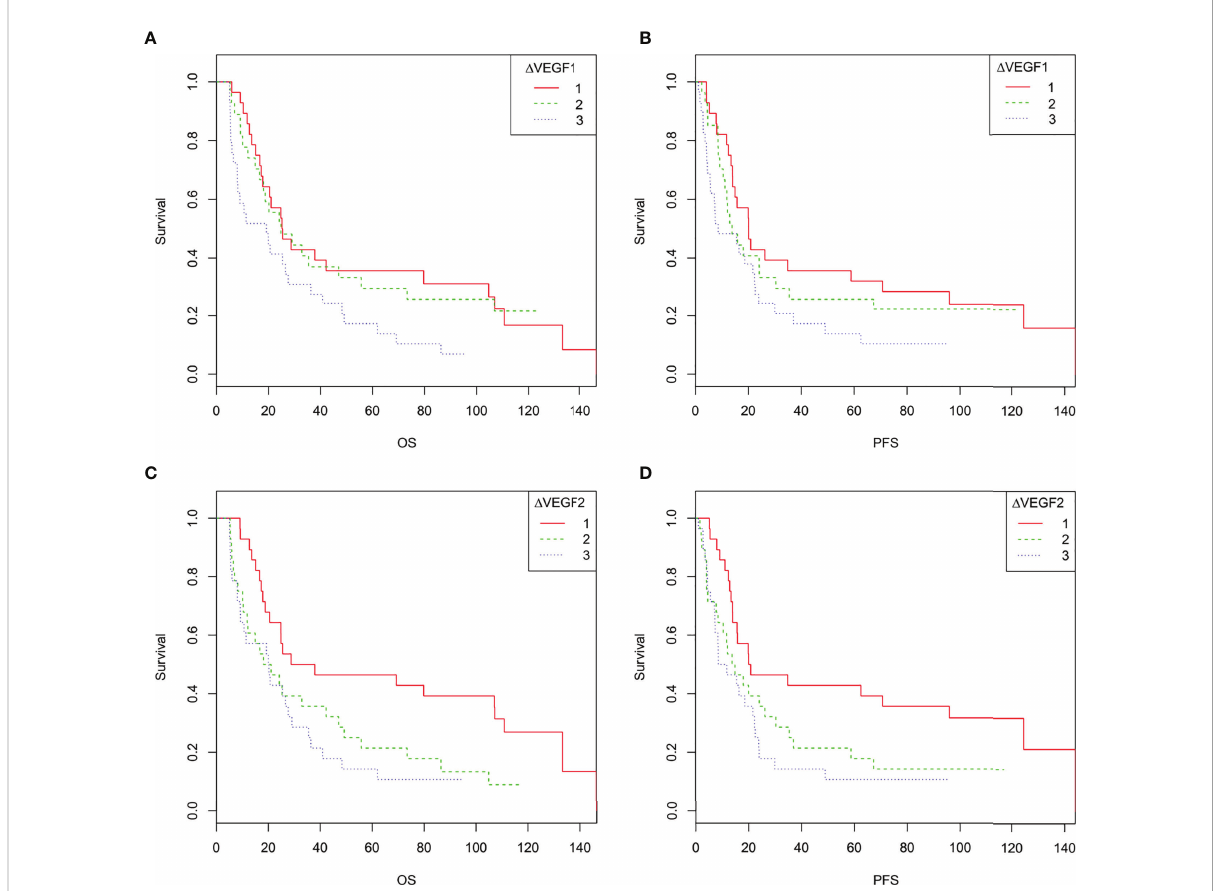
FIGURE 4 (A – D) . Overall survival and progression-free survival curves of patients with different changes in VEGF during and after radiotherapy. 1 indicates decreased VEGF, 2 indicates stable VEGF, 3 indicates increased VEGF. (A, C) : The overall survival curve of ESCC patients with different changes in VEGF during radiotherapy (A) and after radiotherapy (C, D) , the progression-free survival curves of ESCC patients with different changes in VEGF during radiotherapy (B) and after radiotherapy (D)